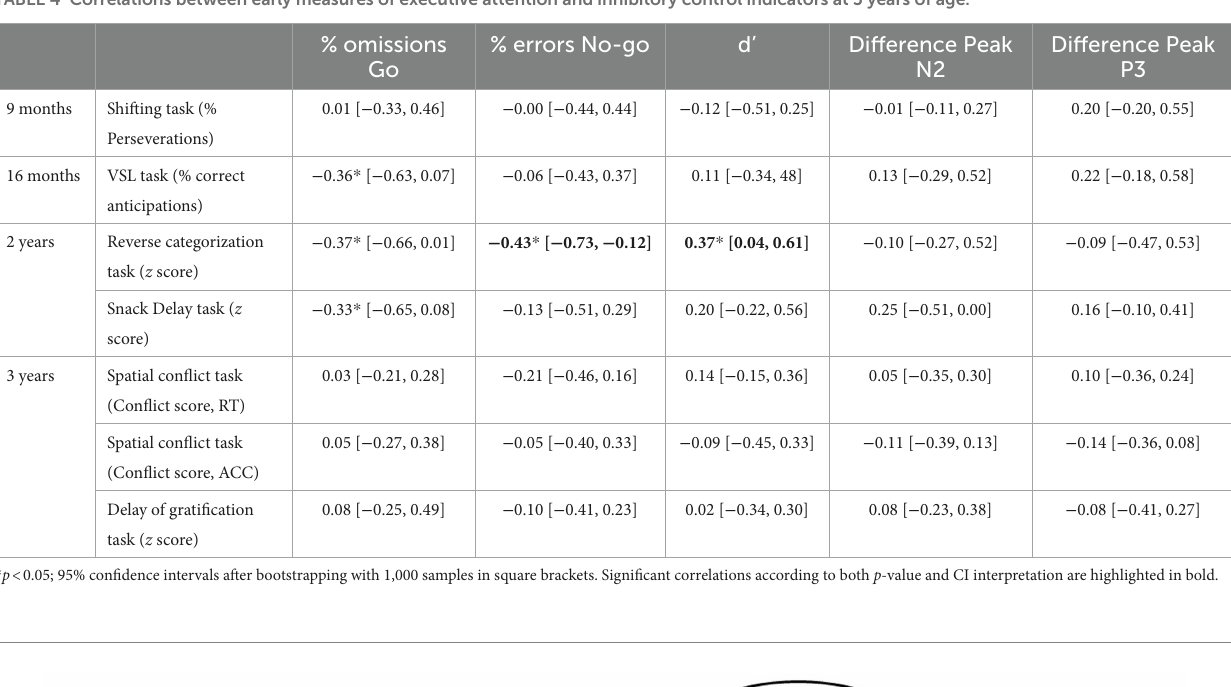
respectively. Both tasks require changing the mindset from the first to the second block of trials having the same structure, presumably tapping the same IC component (Carlson, 2005; Diamond, 2013; Conejero and Rueda, 2017). The only difference between the two tasks is the response modality. While the Shifting task depends on the